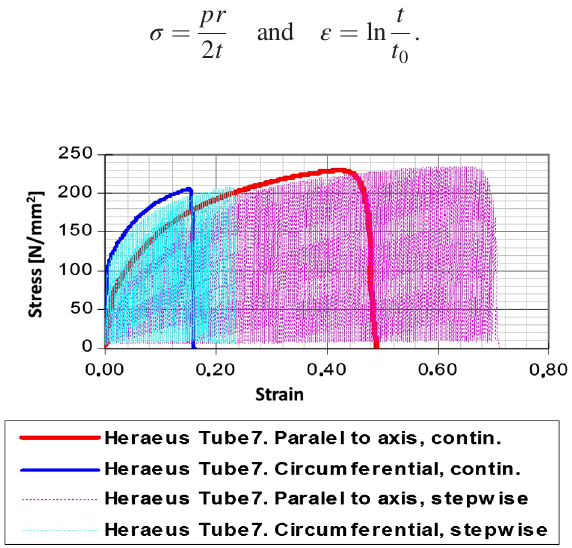
FIG. 2. Comparison of the tensile test result in continuos and pulsed (stepwise) stress regime.